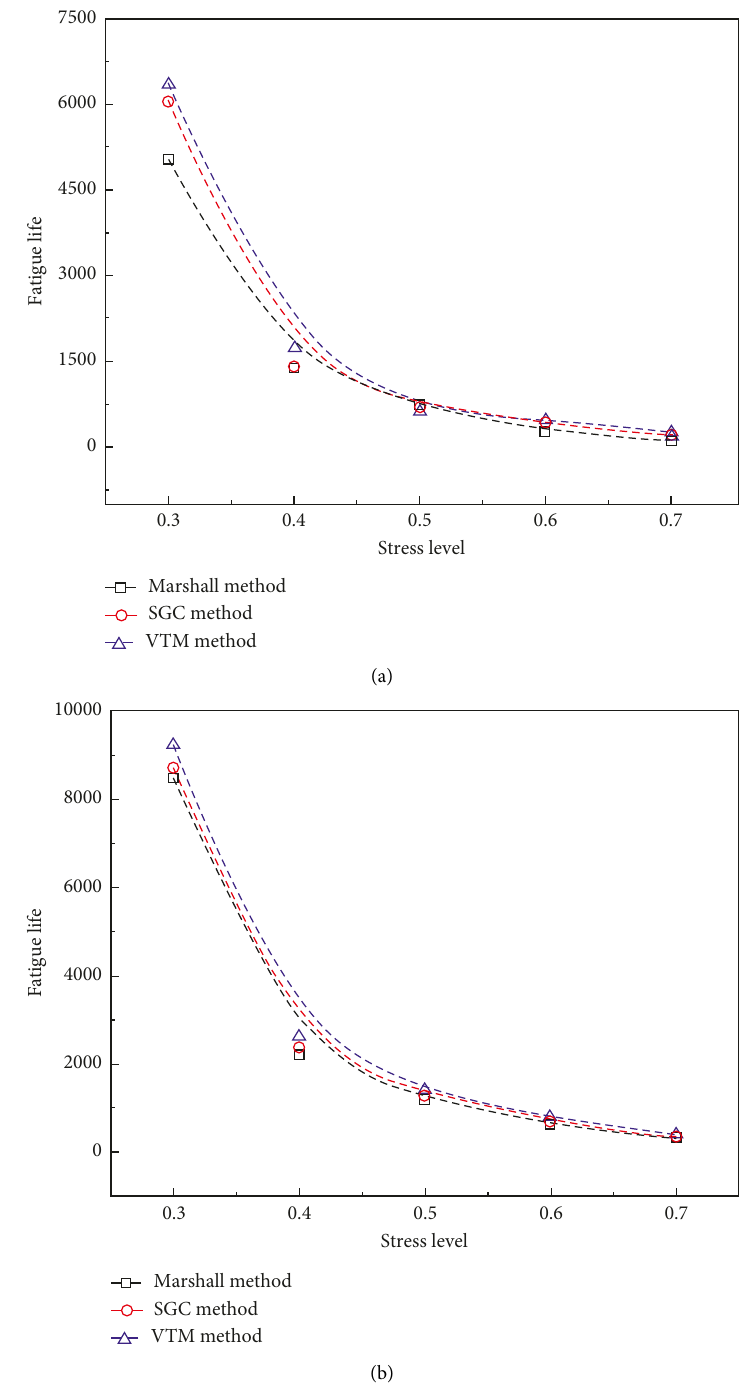
Figure 9: Fatigue life of the SMA-13 mixture with skeleton dense gradation versus stress level under different probabilities of failure. (a) Probability of failure is 5%. (b) Probability of failure is